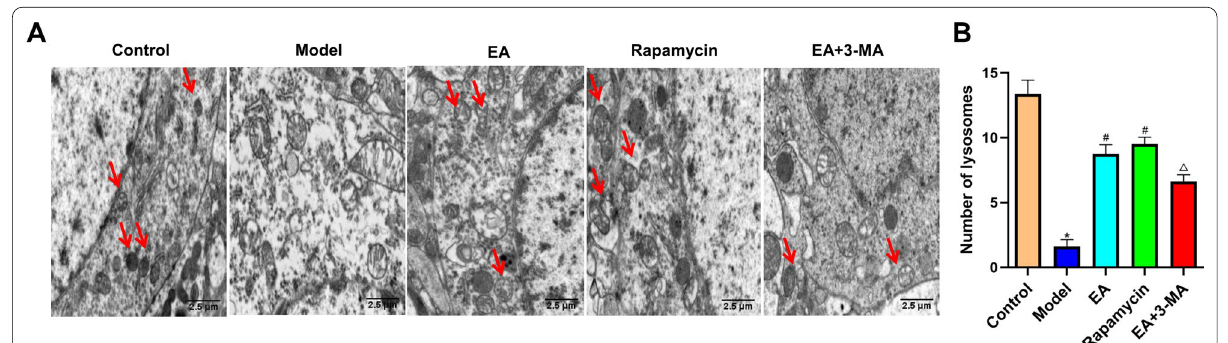
Fig.6 Effect of EA on ultrastructure of hippocampal neurons in diabetic rats. A Electron microscopic pictures of hippocampal neurons in diabetic rats. Scale bar 1 μm, magnification 6000. The protective effects of EA on ultrastructural damage in the hippocampus CA1 area of = × diabetic rats were identified by electron microscopy. B Comparison of the number of autophagic vacuoles in diabetic rats. Data are expressed as mean standard error of the mean ( n 8 in each group). * p < 0.05 versus control group; # p < 0.05 versus model group; △ p < 0.05 versus EA group ± =